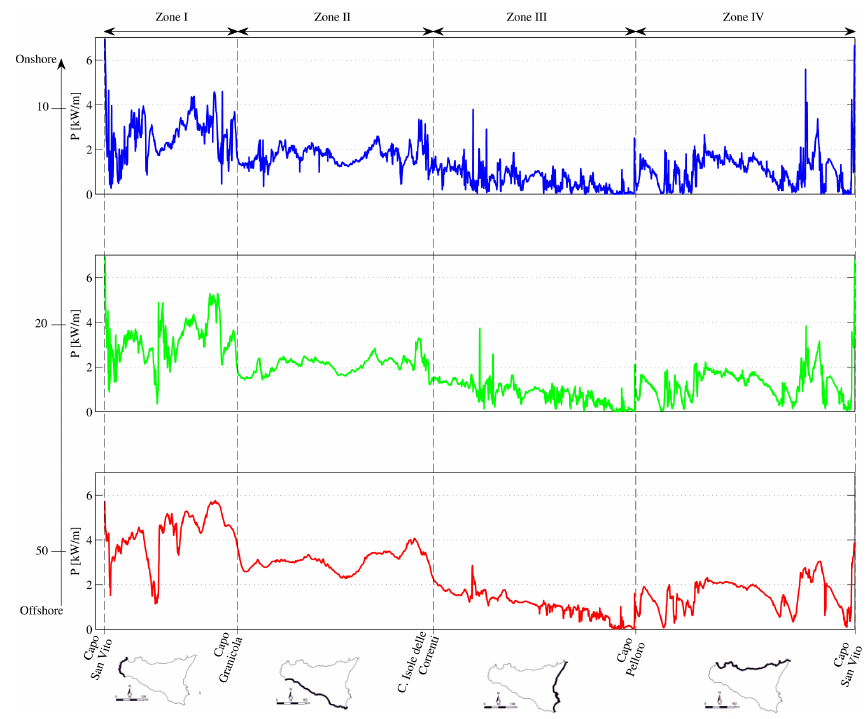
Figure 10. Distribution of the wave energy flux around Sicily estimated along three different isobaths: (a) − 10m; (b) − 20m; (c) −